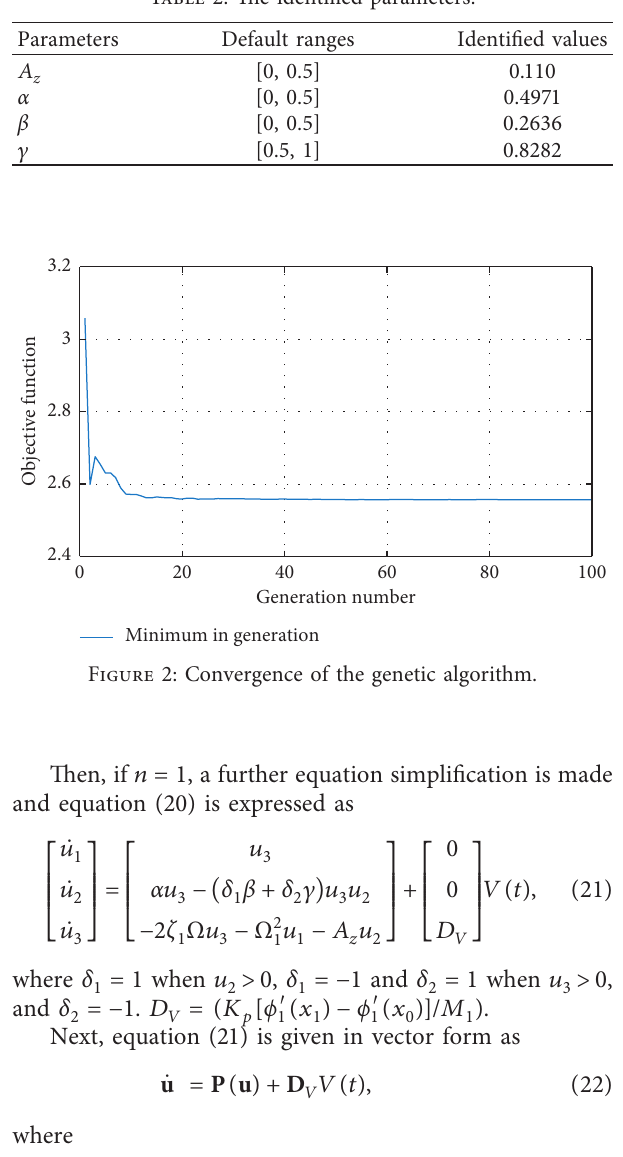
Table 2: The identified parameters.